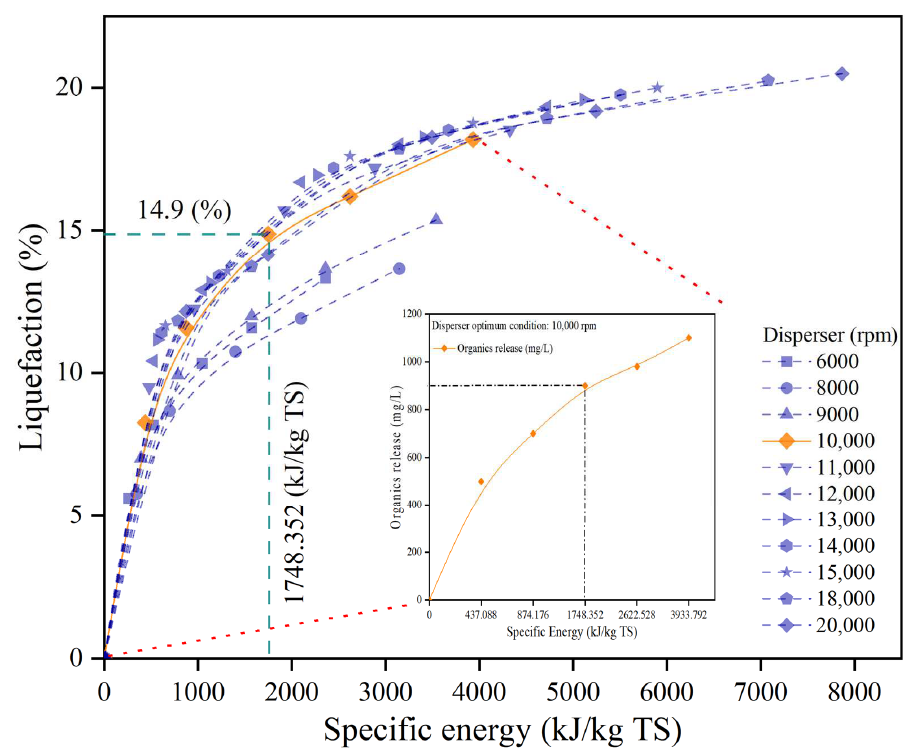
Figure 3. Effect of specific energy on organics liquefaction and effect of specific energy on organic release at optimal disperser condition (10,000